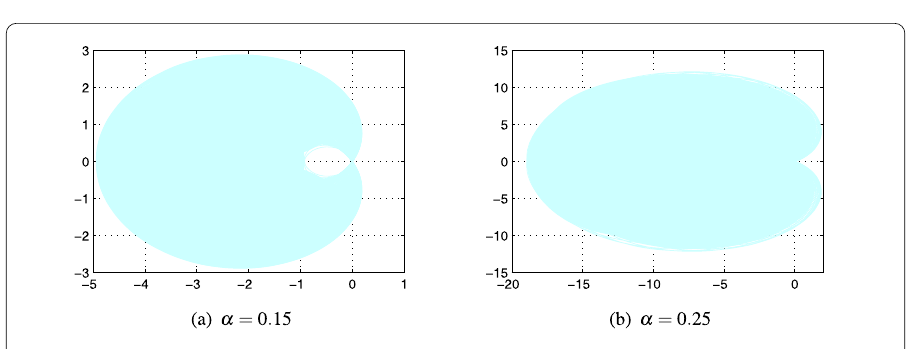
Figure 3 Stability region of numerical algorithm